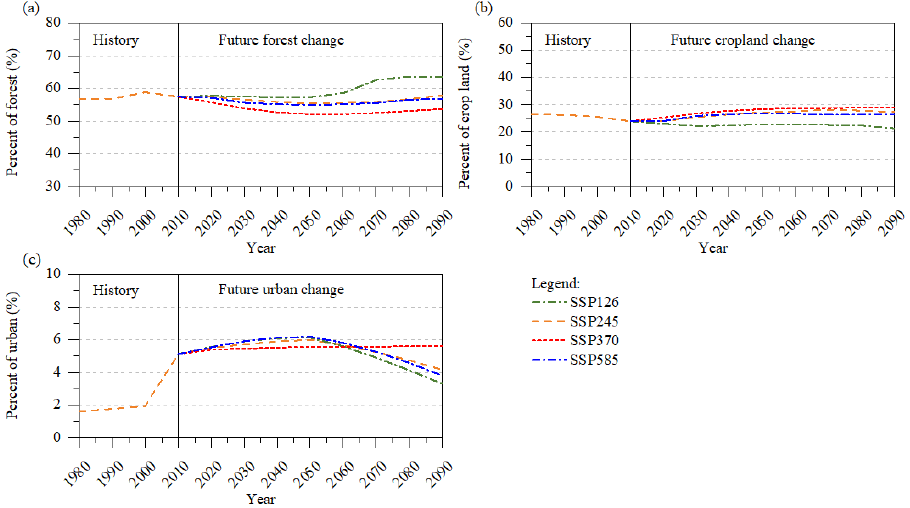
Figure 4. The percent changes of three main land use types (forest ( a ), cropland ( b ) and urban ( c ) areas) with decadal land use changes projected by the CA–Markov model for the 2020-2090 period under the four SSP–RCPs. The land use changes in the historical period (1980–2010) are based on the observed land use maps.